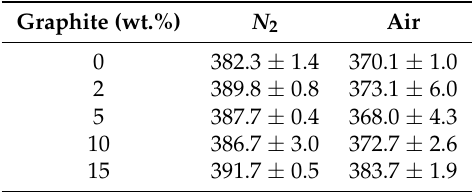
Figure 5. TGA thermograms (heating rate of 10 ◦ C/min) of PET/graphite micro-composites with various graphite contents examined under: ( a ) nitrogen atmosphere; and ( b ) air atmosphere. Table 2. Thermal degradation temperature ( T 5% ) for PET/graphite micro-composites under nitrogen and air